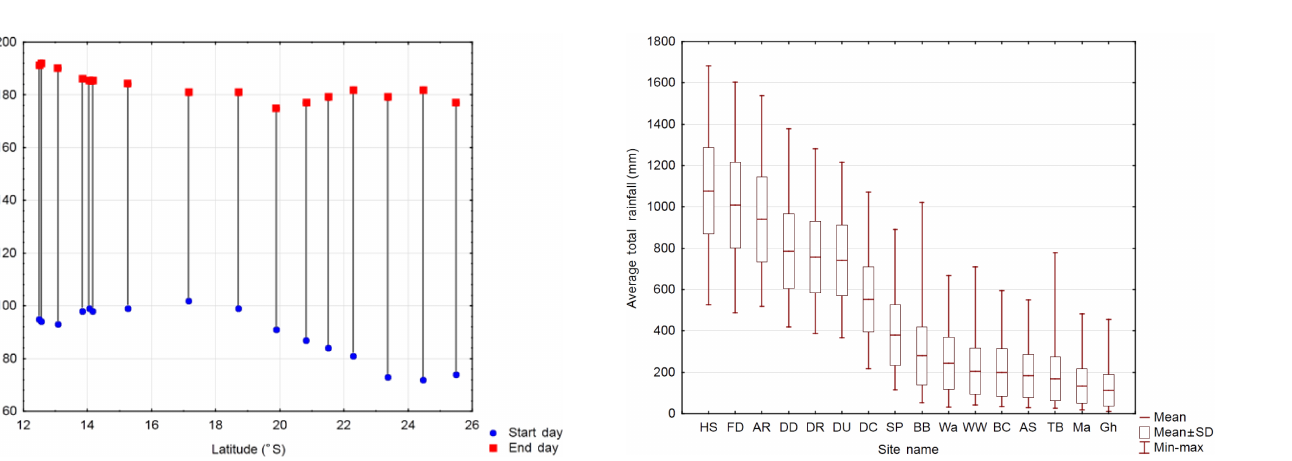
Figure 3. Wet season characteristics for each site along the NATT (Table 1) for the period 1900 to 2010. Sites are plotted as their lat- itude along the transect. Average wet season start day, end day and duration are given. Start and end days are defined as the date when rainfall, between September 1 and April 30 the following year, ex- ceeded 15 and 85%, respectively, of the total rainfall between these two dates (I. N. Smith et al., 2008a). Start and end days are dis- played as the number of days from 1 September. Wet season dura- tion is shown by the grey line connecting start and end days.